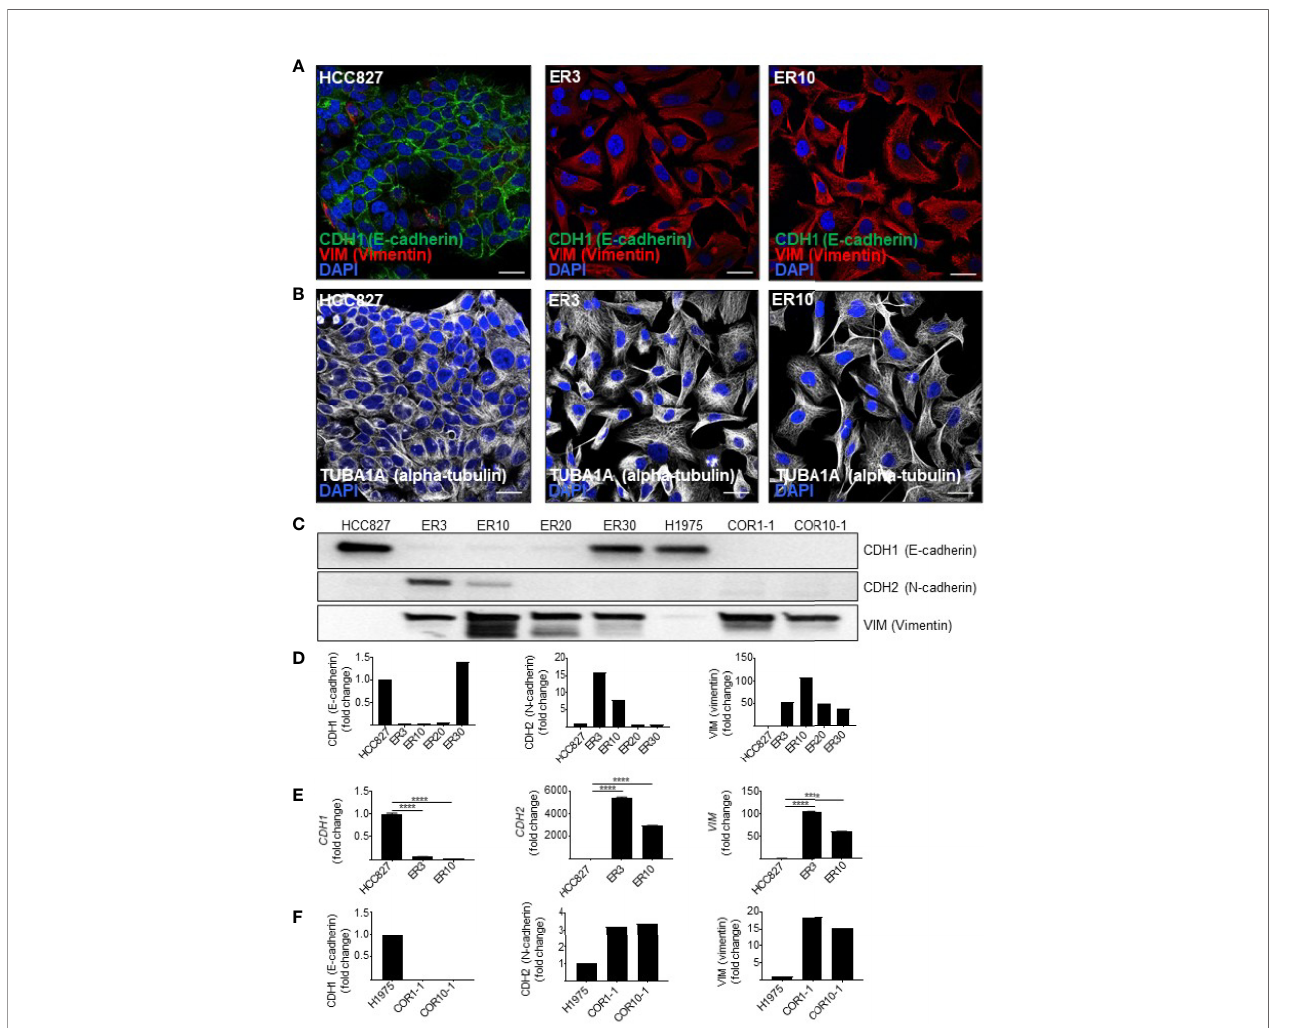
FIGURE 1 | Resistance to fi rst- and second-generation EGFR inhibitors is associated with features of EMT. (A) Immunocytochemistry of HCC827 parental cells and the erlotinib-resistant clones ER3 and ER10 for the epithelial marker CDH1 (E-cadherin) and the mesenchymal marker VIM (vimentin) to examine markers of epithelial plasticity upon acquired drug resistance. Counterstain by DAPI. Scalebar = 30 m m. (B) TUBA1A (alpha-tubulin) immunocytochemistry of the cells described in (A) were applied to reveal the phenotypic shift in cell morphology. Counterstain by DAPI. Scalebar = 30 m m. (C) Western blots were prepared with lysates from the HCC827 parental cells and the erlotinib-resistant clones ER3, ER10, ER20, and ER30 H1975 parental cells and the clones COR1-1 and COR10-1 resistant to the second- generation EGFR inhibitor rociletinib. Immunodetection of epithelial marker CDH1 (E-cadherin) (135 kDa), mesenchymal markers CDH2 (N-cadherin) (135 kDa), VIM (vimentin) (54 kDa). Western blot analysis was repeated n = 3 times, and a representative experiment is presented in the fi gure. (D) Quanti fi cation of the western blot presented in (C) normalized against total protein presented in Supplementary Figure 1A (VIM and CDH1) and B (CDH2). Fold change values for the resistant clones ER3 and ER10 relative to their parental cell line HCC827 (E) Expression of transcripts encoding CDH1, CDH2, VIM , assessed by RT-qPCR on cDNA prepared from HCC827 parental, ER3, and ER10 cells. RT-qPCR analyses were repeated n = 3 times, and representative results from one experiment with n = 3 technical replicates are presented in the fi gure as mean fold change +/- SD calculated by the 2 – DD Ct method. Two-way ANOVA followed by Tukey ’ s multiple comparison test comparing ER3 and ER10 against the parental cell line showed that for all genes, the gene expression of all genes in both ER3 and ER10 were signi fi cantly different from the parental cells ( P < 0.0001). (F) Quanti fi cation of the western blot presented in (C) normalized against total protein presented in Supplementary Figure 1A (VIM and CDH1) and B (CDH2). Fold change values for the resistant clones COR1-1 and COR10-1 relative to their parental cell line H1975. ****P ≤